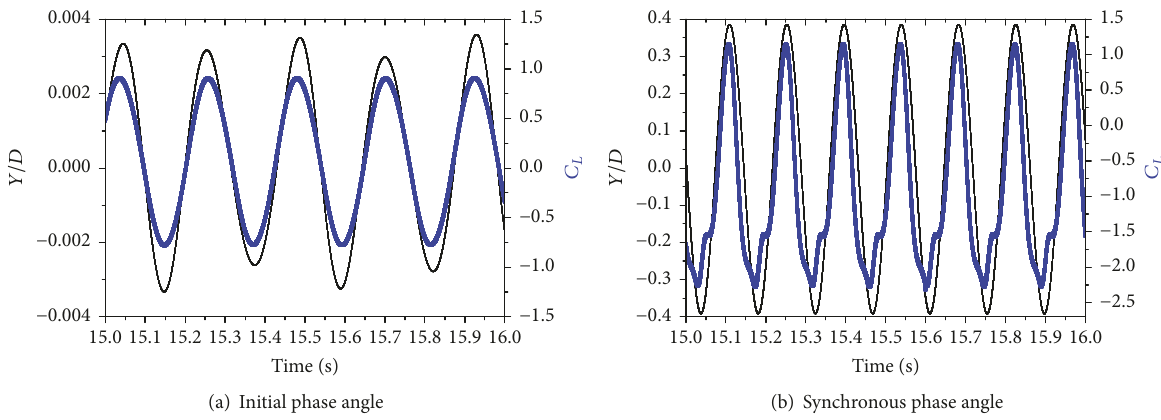
Figure 14: Results of phase angle in initial and synchronization state for 𝛼 = 30 ∘ / 𝛼 = 60 ∘